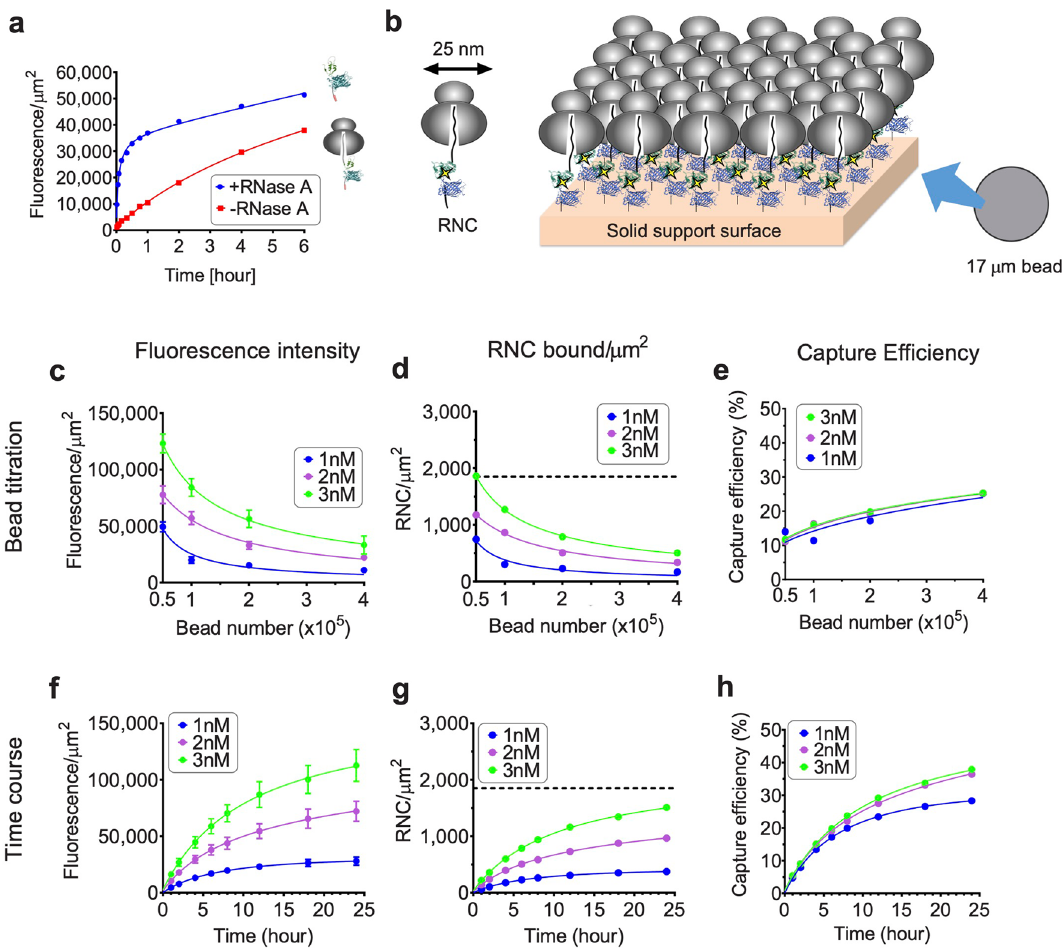
Figure 2. RNC capture is dependent on RNC concentration, binding time, and bead number. ( a ) Time course of bead binding for 2 × 10 5 of 17 µm beads and 2 nM purified RNCs (His 10 -CFP-NBD1, donor only) ± RNase A treatment. ( b ) Cartoon depicting ribosome binding geometry on solid support surface assuming smooth surface. Diameter of ribosome is approximately 25 nm, yielding RNC saturation density of: η h (1 µm) 2 /( π r 2 ) = 1,850 ribosomes/µm 2 , where η h is the coefficient of densest packing of circle in the plane, and r is radius of ribosome. ( c – e ) Effect of bead number on RNC binding. 1, 2, or 3 nM RNCs (His 10 -CFP-NBD1, donor only) were incubated with 0.5–4 × 10 5 of 17 µm beads for 6 h. ( f – h ) Effect of incubation time on RNC binding. 1, 2, or 3 nM RNCs (His 10 -CFP-NBD1 donor only) incubated with 2 × 10 5 of 17 µm beads for times indicated. Fluorescence intensity of 17 µm beads in panels c and f are shown in mean ± SD (n = ~ 400 beads). Binding density in panels d and g was calculated using number of protein molecules bound per total calculated surface area of beads added. Dotted line in panels d and g indicates theoretical RNC saturation density as described in panel b . Capture efficiency in panels e and h was calculated by RNCs bound/RNCs in binding